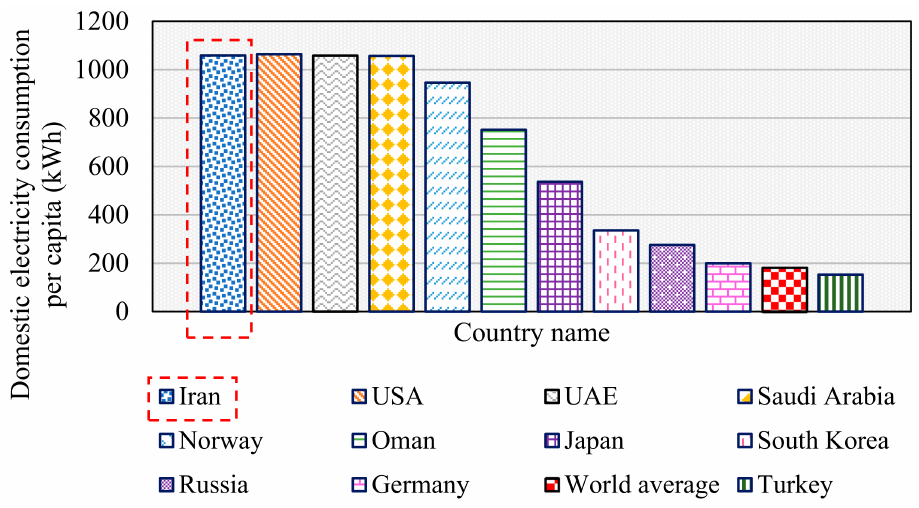
Figure 17. Domestic electricity consumption per capita in different countries and Iran.